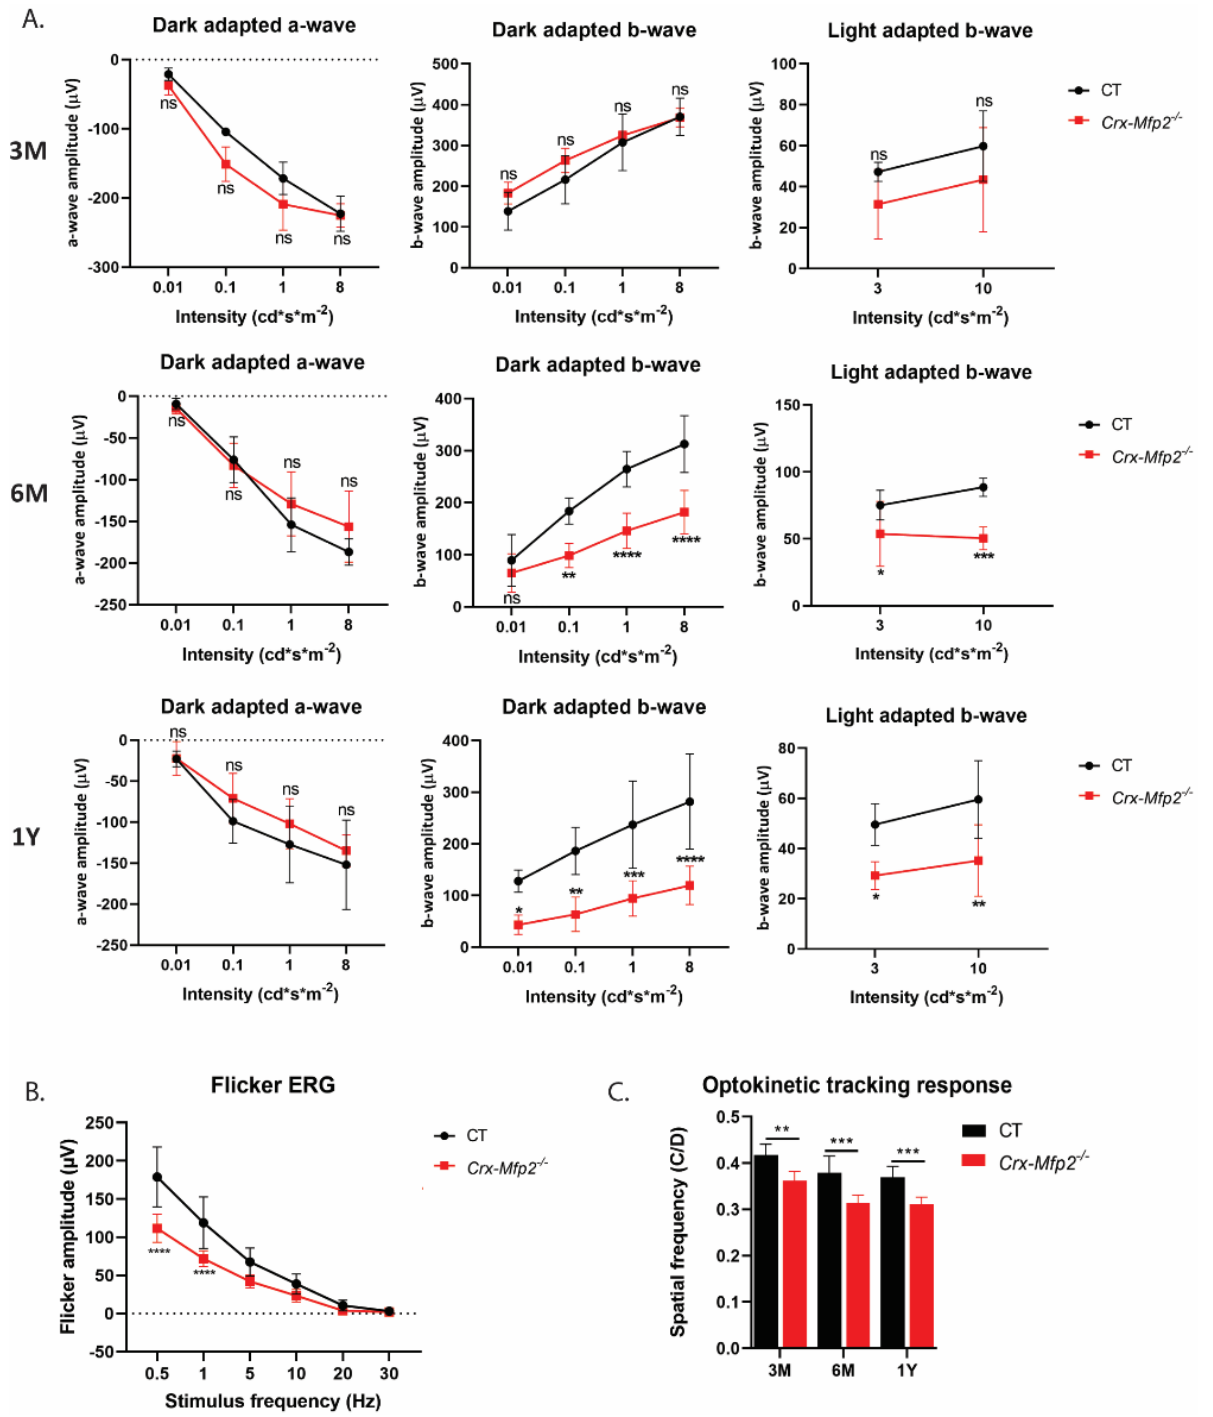
Figure 4. Reduced visual acuity and function in Crx-Mfp2 − / − mice. ( A ) No change in scotopic a-wave between control and Crx-Mfp2 − / − mice at any investigated age. The scotopic and photopic b-wave was significantly reduced in 6 M and 1 Y old Crx-Mfp2 − / − mice. ( B ) Flicker ERG responses were impaired (6 M). ( C ) Optokinetic tracking response showed a significant reduction in visual acuity at 3 M, 6 M and 1 Y. N = 4–8/group. Statistical difference based on unpaired t-test and two-way ANOVA: * p < 0.05, ** p < 0.01, *** p < 0.001, **** p < 0.0001; ns—not significant. Error bars indicate